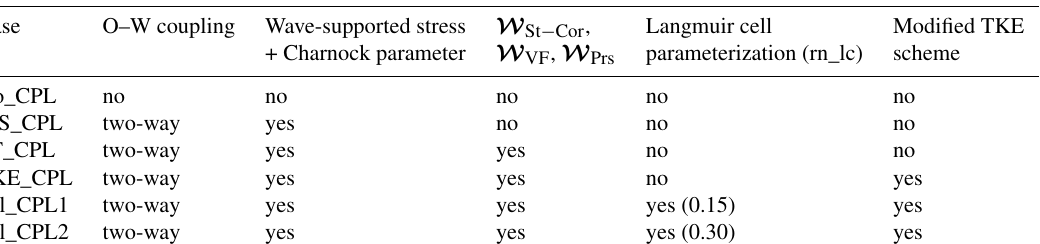
Table 2. Various model configurations analyzed in Sect. 4.2.